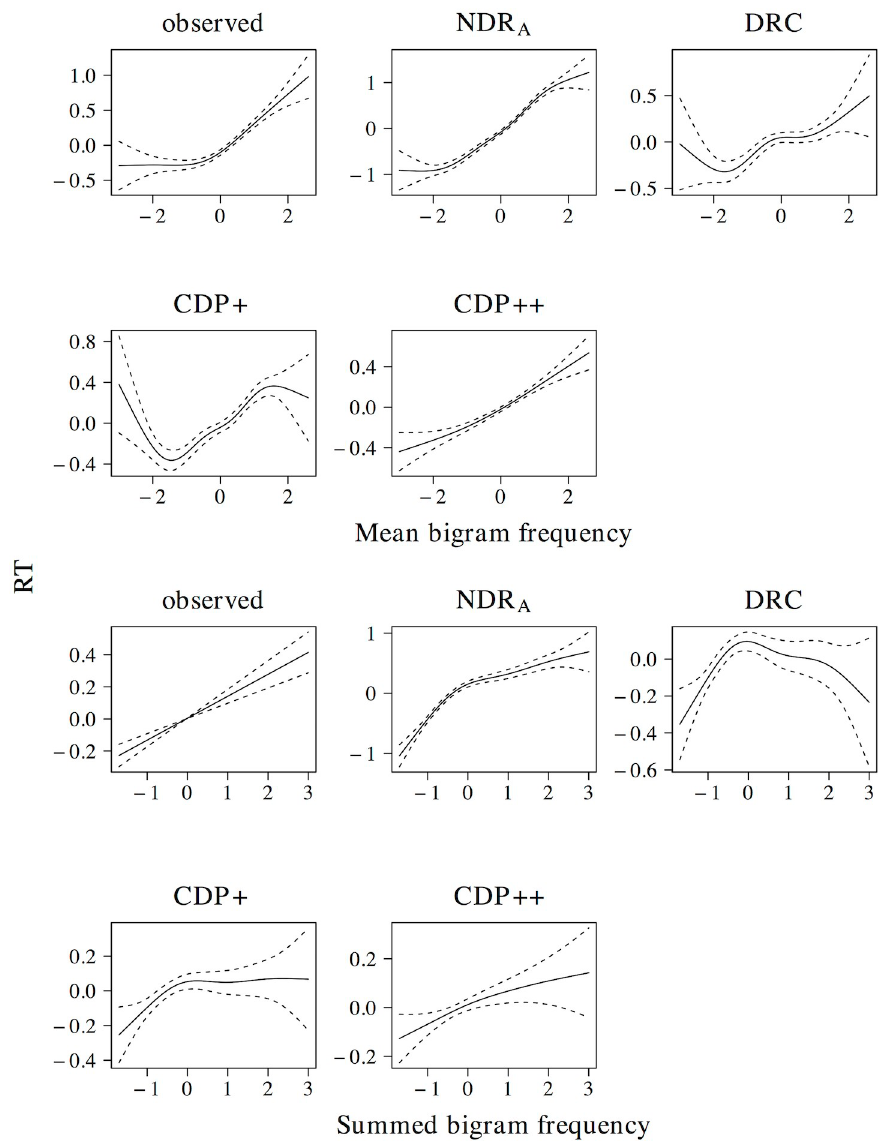
Fig 18. Mean bigram frequency and summed bigram frequency. The effects of mean bigram frequency (top two rows) and summed bigram frequency (bottom two rows) in word naming.